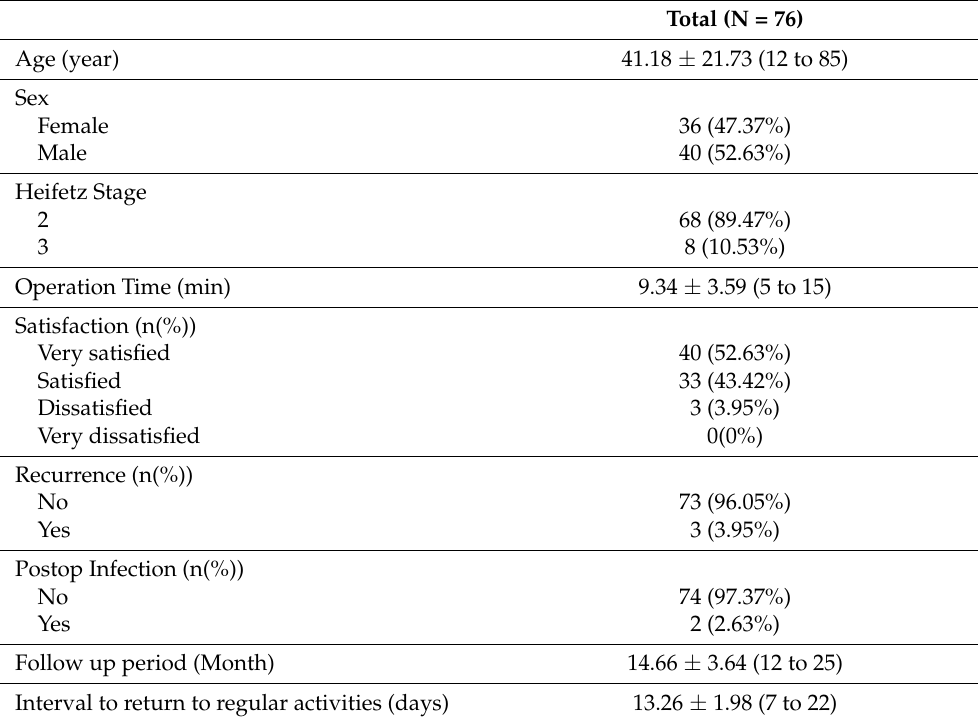
Table 1. Clinical patient characteristics and outcome after